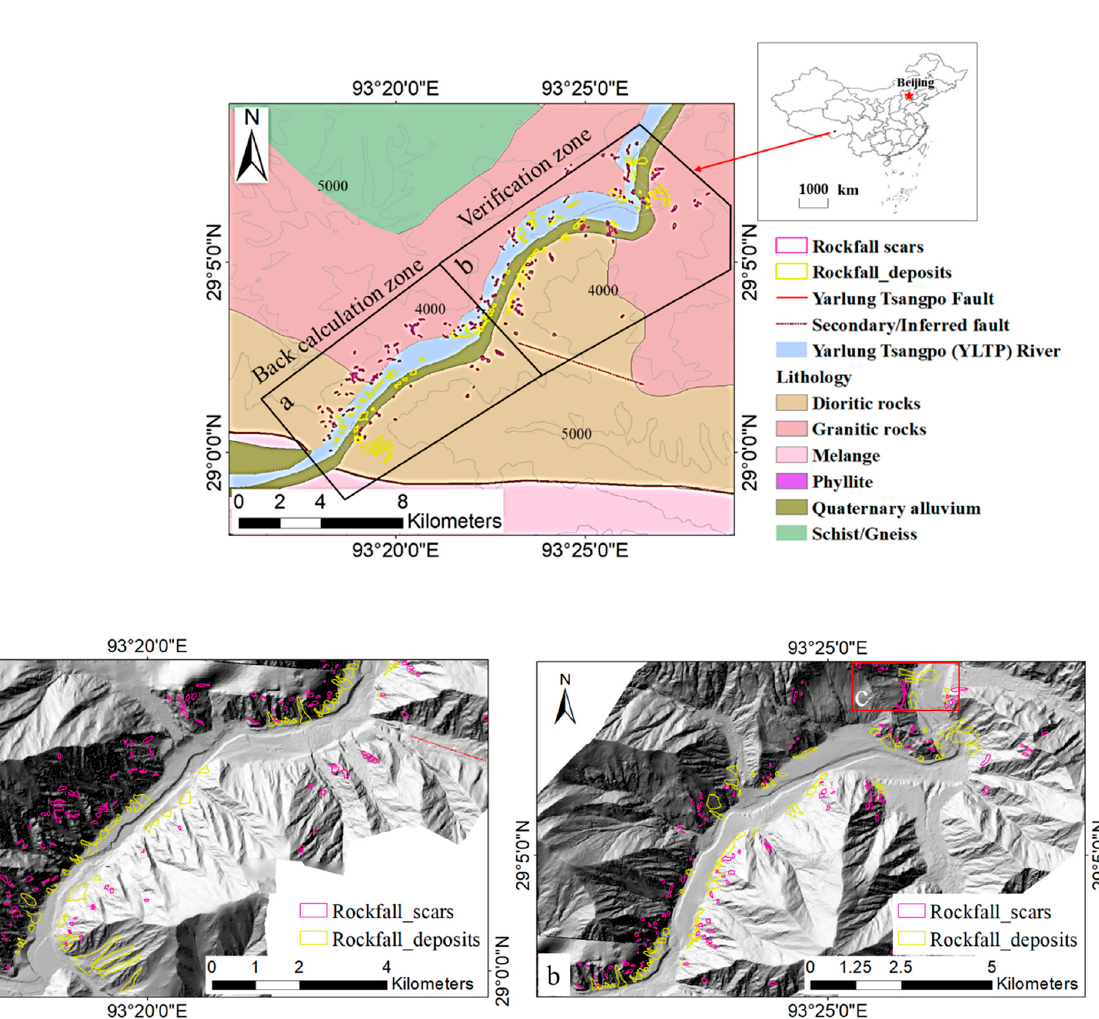
Figure 1. Simplified geology map of the study area. Two zones are separated by the space partition for validation of the prediction result, with ( a ) the back calculation zone and ( b ) the verification zone. ( c ) Sample area presented in Figure 2.